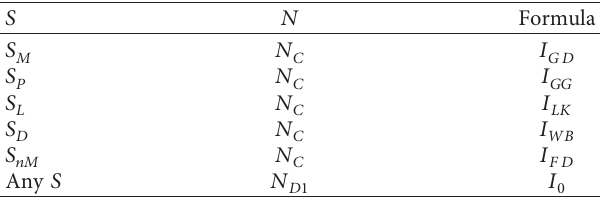
Figure 4: Intersection between families of R - and R ′ -operations (respectively, implications). Table 7: Basic R ′ -implications.